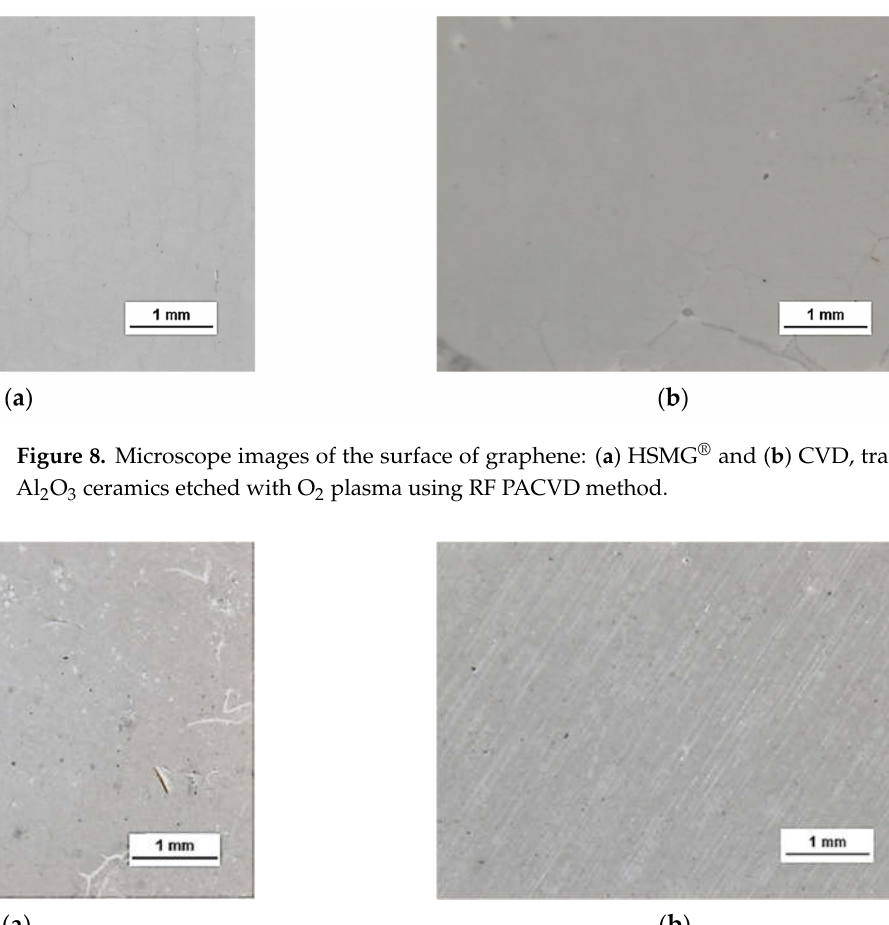
Figure 7. Microscope images of the surface of graphene: ( a ) HSMG ® and ( b ) CVD, transferred to Al 2 O 3 ceramics etched with barrier discharge plasma (DBD).